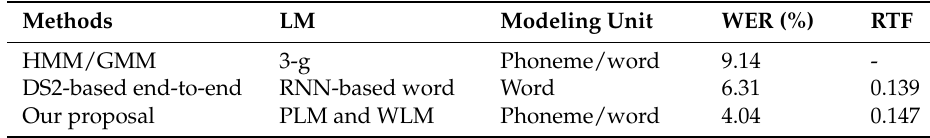
Table 5. Performance of different ASR models. HMM/GMM: Hidden Markov Model and Gaussian